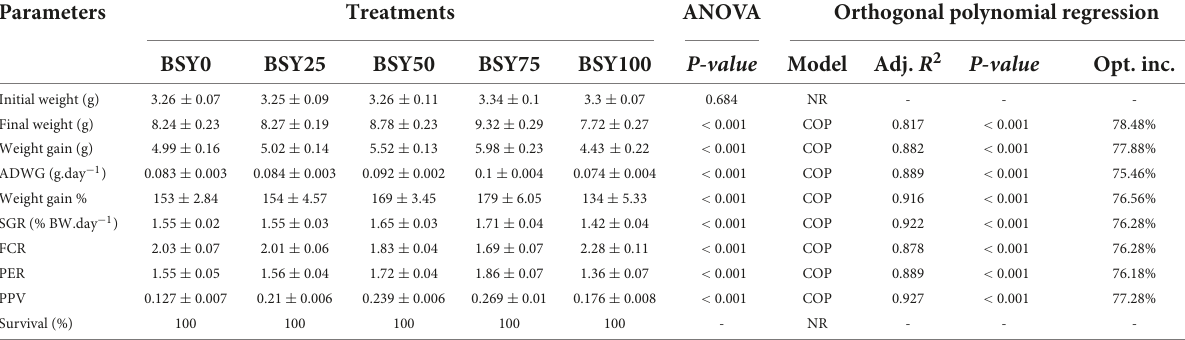
TABLE 2 Growth performance and feed utilization of climbing perch fingerlings to the BSY incorporated diets. Parameters